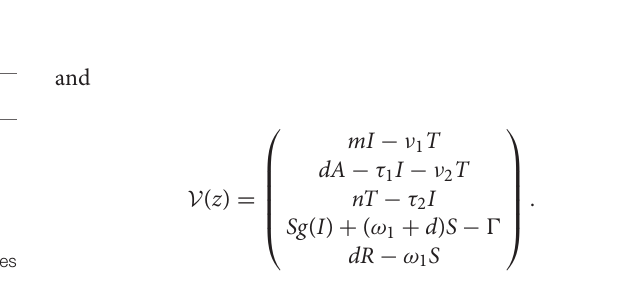
FIGURE 1 | Flow diagram.